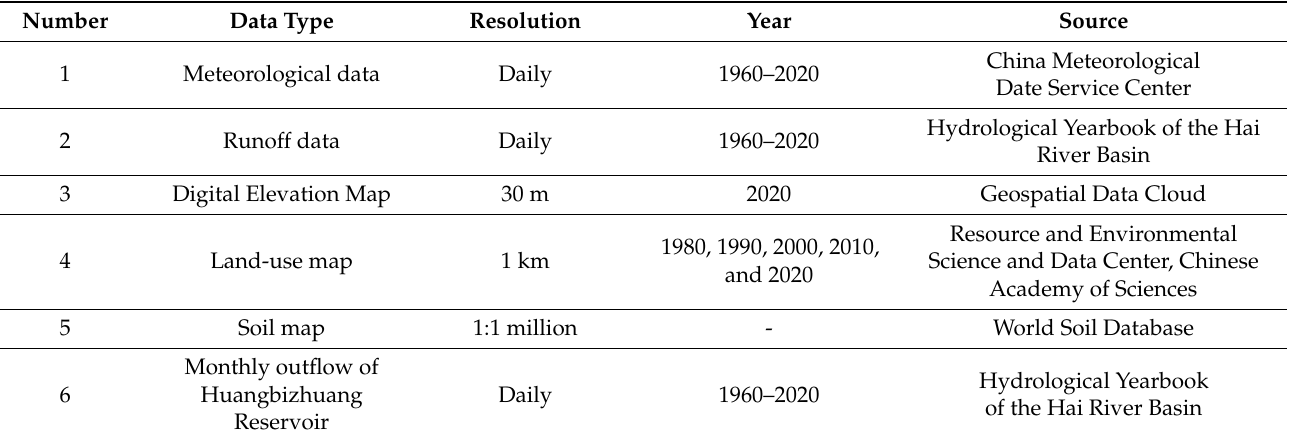
Table 1. Characteristics of data used for the study.